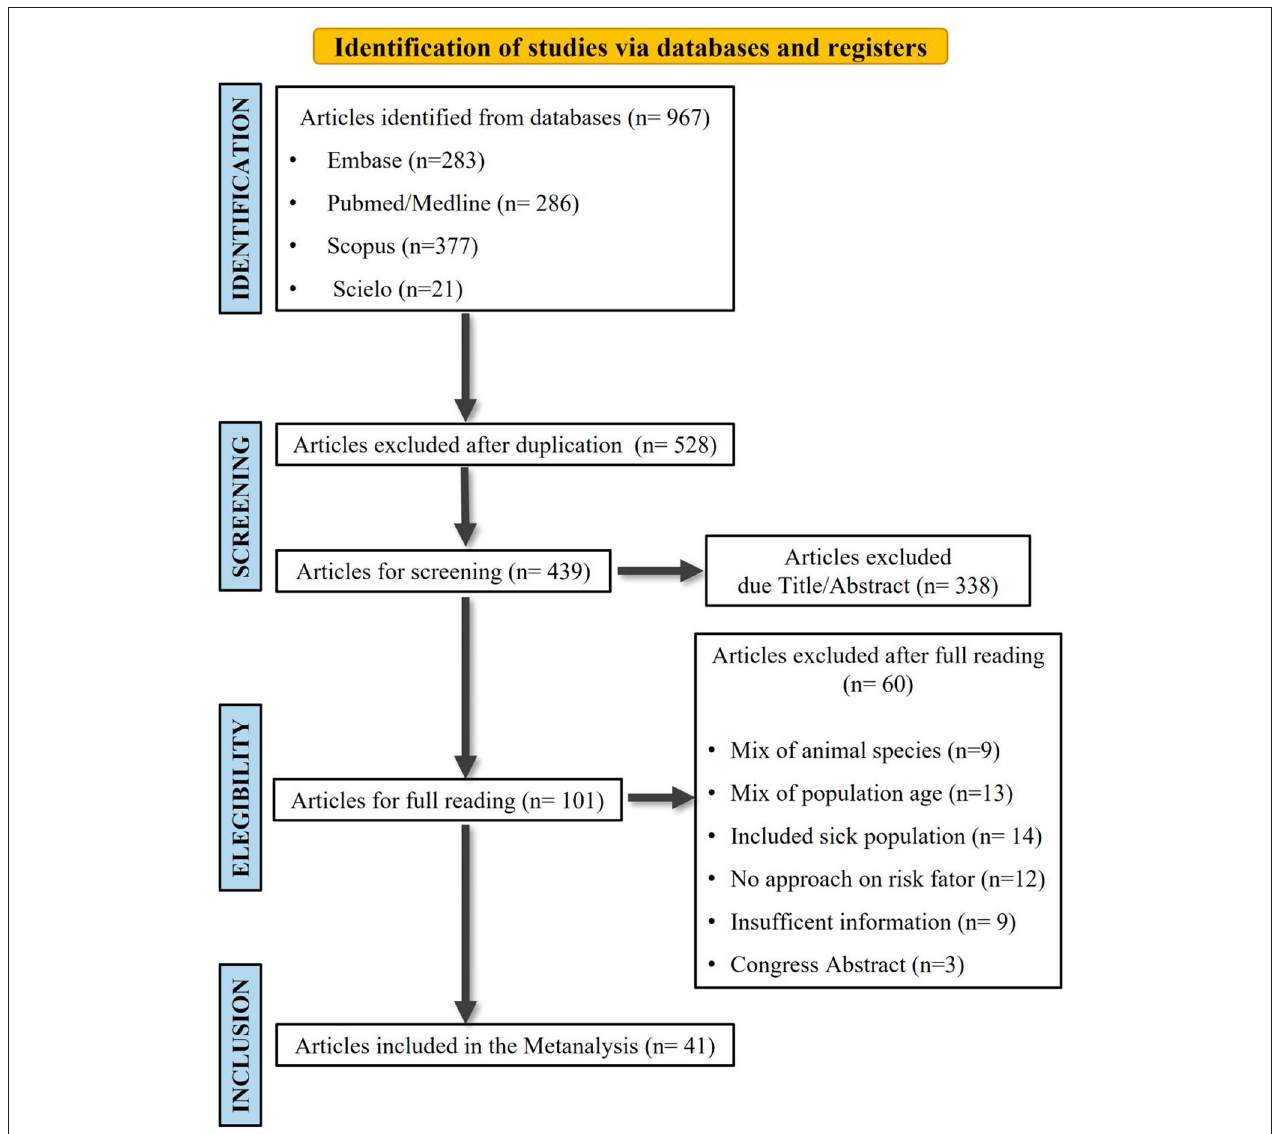
FIGURE 1 | Flow-chart representing study search and selection strategy on seropositivity of (IgG) anti- Toxocara antibodies and contact with dogs and/or cats in articles of different databases included in the meta-analysis study, from 2009 to 2021.